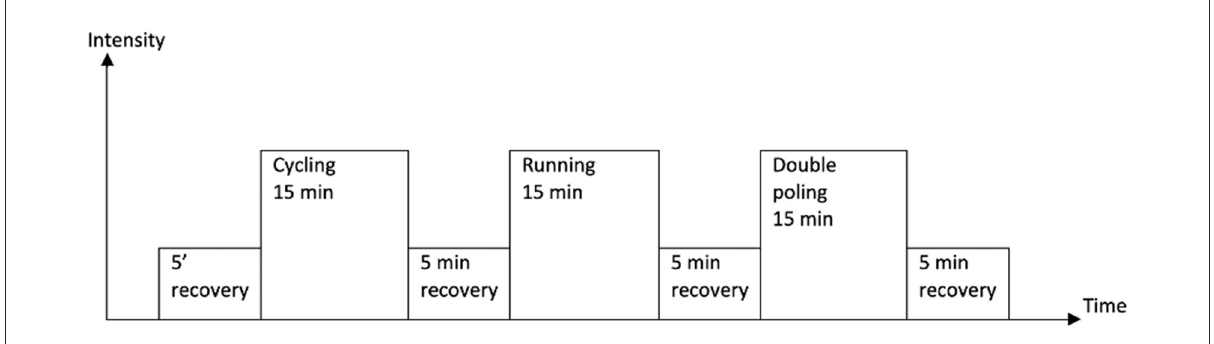
FIGURE3 Test protocol for the pilot test of the ECG247. Started with applying the sensor and connect to the participants phones. Recovery consisted of walking and sitting. The intensity increased slightly every 5min during the efforts.